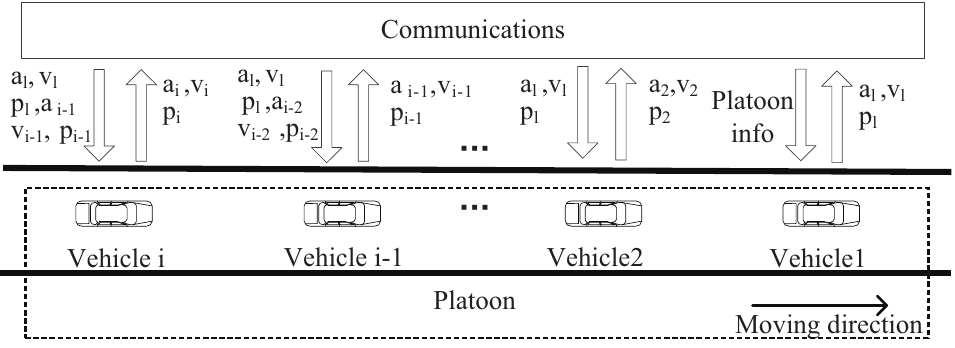
Figure 2. Platoon communication